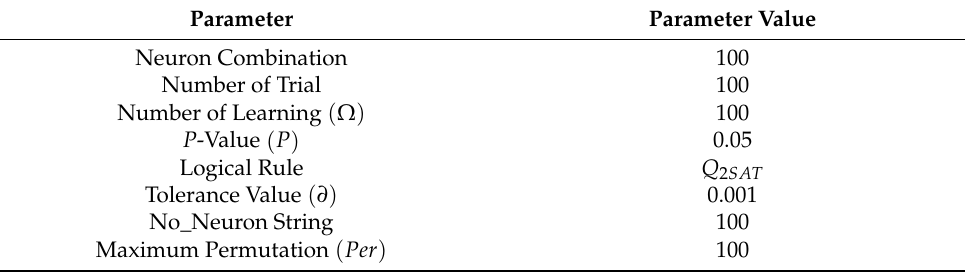
Table 2. List of parameters in S2SATRA.